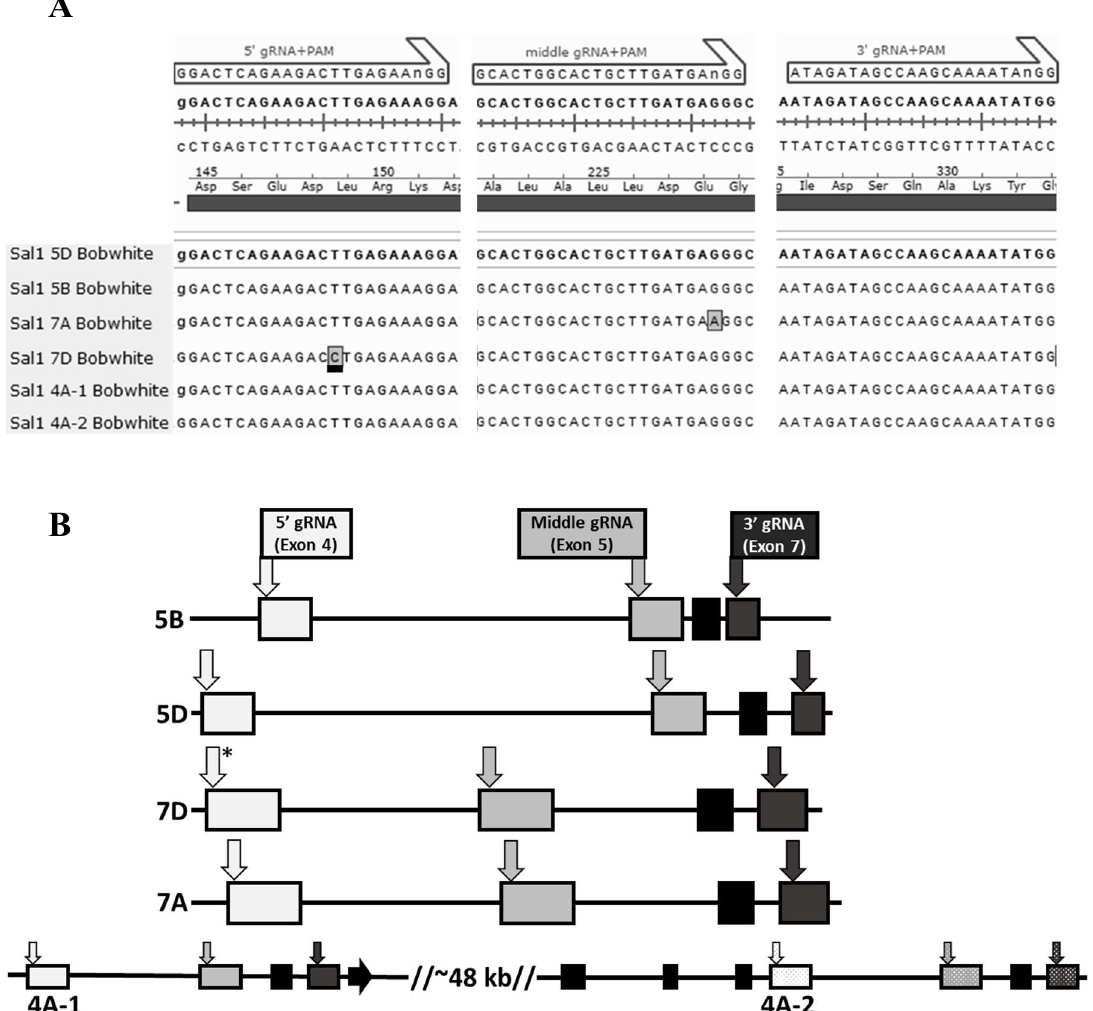
Figure 1. CRISPR targeted regions in the wheat Sal1 gene family. ( A ) Conserved regions of wheat Sal1 genes targeted by CRISPR editing. The underlined boxed residue indicates a 1 basepair mismatch in the Sal1 7D 5′ target site sequence. ( B ) Diagram showing the location of the target sites in the six Bobwhite Sal1 genes. Black lines indicate introns and boxes denote exons. The Sal1 4A−1 and Sal1 4A−2 genes are in tandem on chromosome 4A, separated by approximately 48 kilobases (kb). The asterisk indicates the mismatch to the Sal1 7D 5′ target sequence.